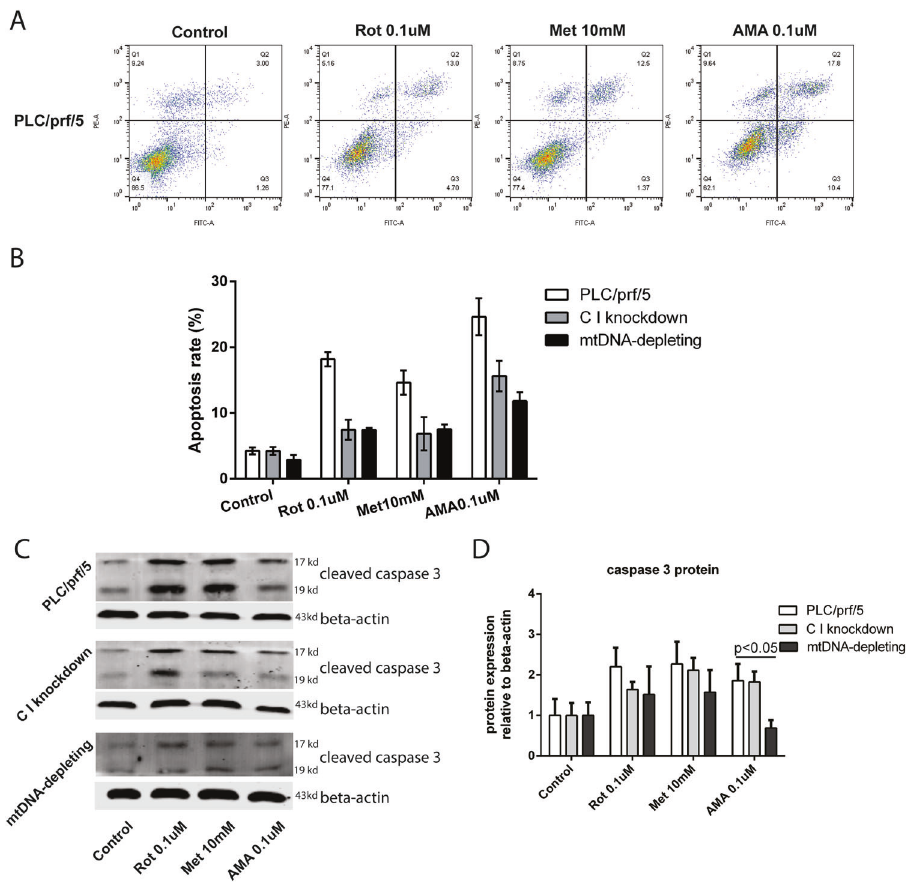
Fig. 5 Inhibition of mETC complexes induced apoptosis. A Apoptotic cells were quanti fi ed by fl ow cytometry using Annexin V and propidium iodide co-staining in PLC/PRF/5 cells. The effects of treatment with ROT, Met or AMA for 48 h is shown ( N = 3). B After treating cells with complex I and III inhibitors (ROT, Met, and AMA) for 48 h, the apoptotic rates of three HCC cell lines (PLC/PRF/5, C I knockdown, and mtDNA depleting) were quanti fi ed by fl ow cytometry. Results were presented as mean ± SD ( N = 3). C, D Three conditions (PLC/PRF/5, C I knockdown, and mtDNA-depleted cells) are shown in presence or absence of ROT, Met, and AMA, following a 48 h incubation. The levels of cleaved caspase-3 protein were measured by the Western blotting analysis and quanti fi ed by the Image J software. Results were presented as mean ± SD, and group differences were tested by Mann – Whitney U